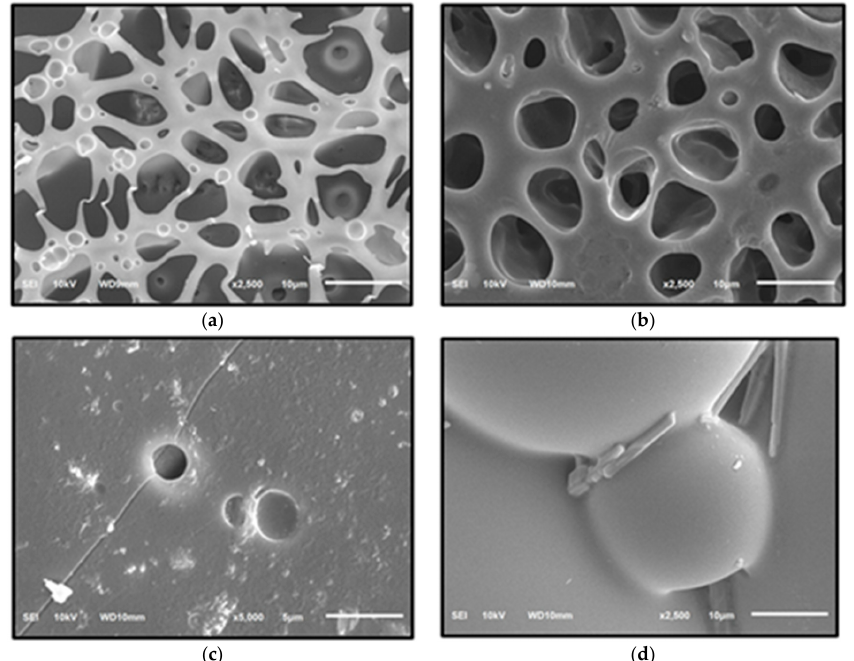
Figure 2. PMMA microstructures: ( a ) PMMA; ( b ) PMMA-H 2 SO 4 ; ( c ) PMMA-HCl; ( d ) PMMA-10% NaOH.